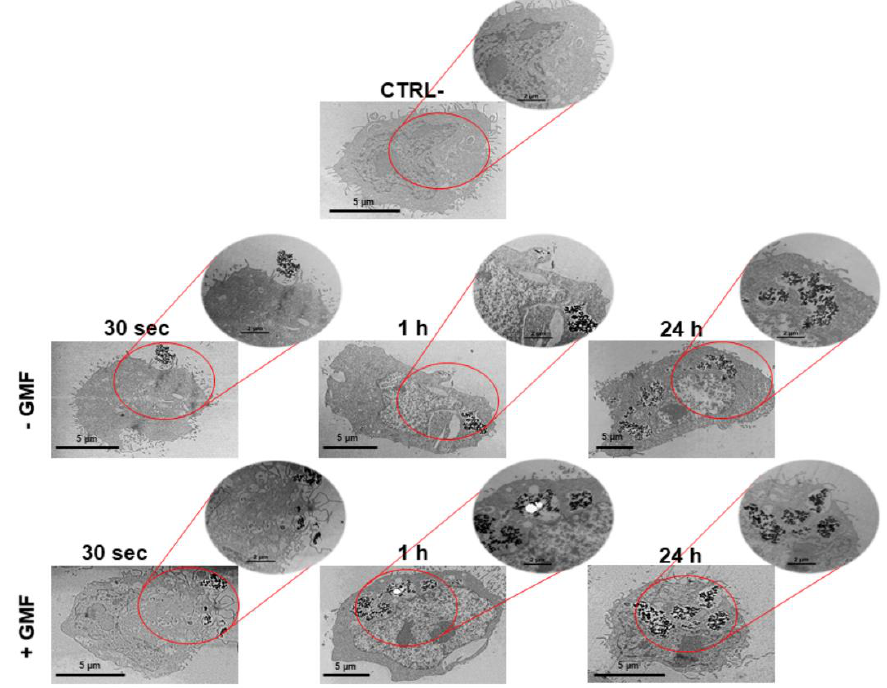
Figure 3. Interaction of BMNPs with 4T1 cells in the presence/absence of a continuous gradient magnetic field analyzed at TEM: Micrographs of the cells incubated with the 100 µg/mL of BMNPs for different periods of time. The micrographs are representative of alternate serial cuts of the cell pellets of each sample. Scale bar: 5 µm.